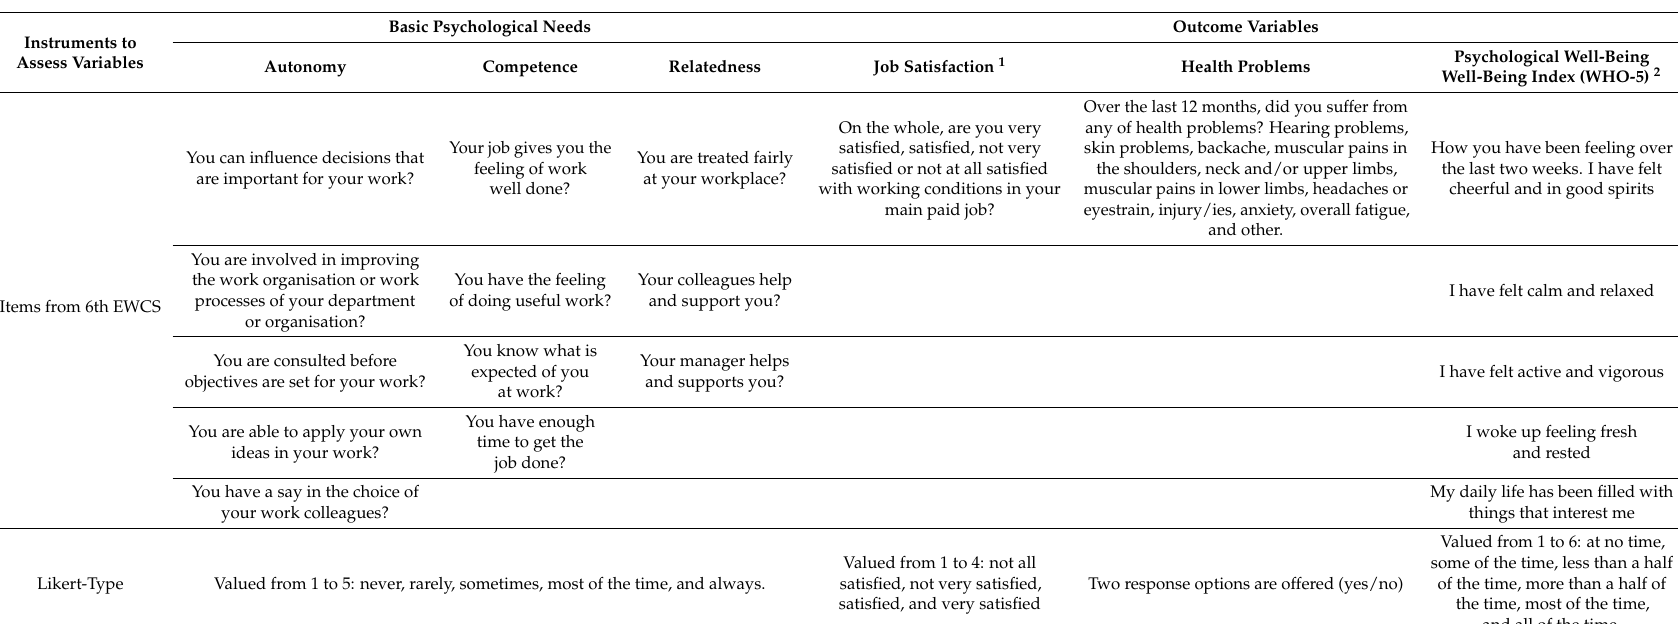
Table 1. Items related to basic psychosocial needs and outcomes in the 6th European Working Conditions Survey (EWCS)